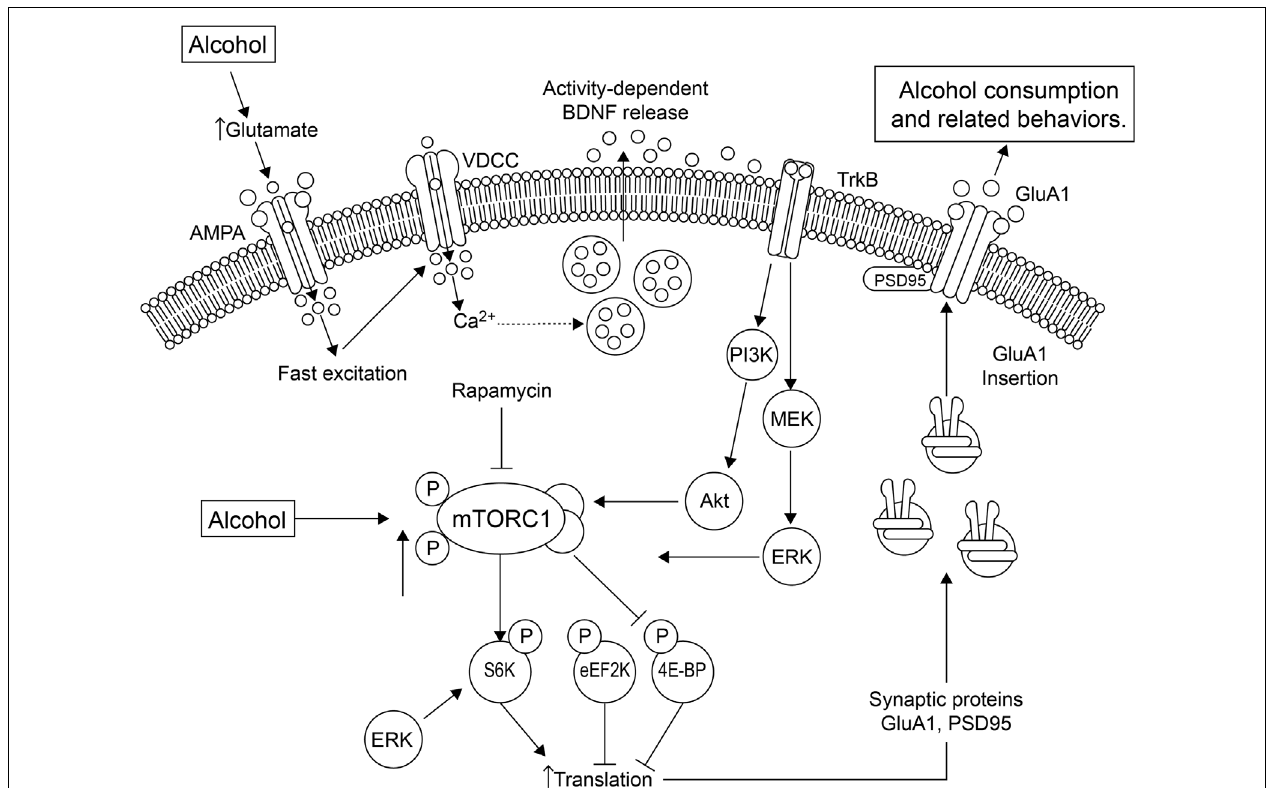
FIGURE 1 |Alcohol affects local translation of proteins in amygdala of alcohol-dependent rats. Alcohol exposure using conditioning chambers, as well as a non-pharmacologically active alcohol injection (priming) that served as an odor-taste cue, increased mTORC1 (mammalian target of rapamycin complex 1) activation and the phosphorylation/activation of its downstream substrates, such as eukaryotic translation initiation factor-4E binding protein (4E-BP), S6 kinase (S6K) and the S6K substrates, and increased expression of post-synaptic density-95 (PSD95) and the AMPA receptor GluA1 subunit (Barak etal., 2013). These effects were abolished by the mTORC1 inhibitor, rapamycin. A second pathway by which alcohol mediates synaptic translation is by increasing extracellular glutamate. This leads to activation of voltage-dependent Ca 2 + channels (VDCCs) and